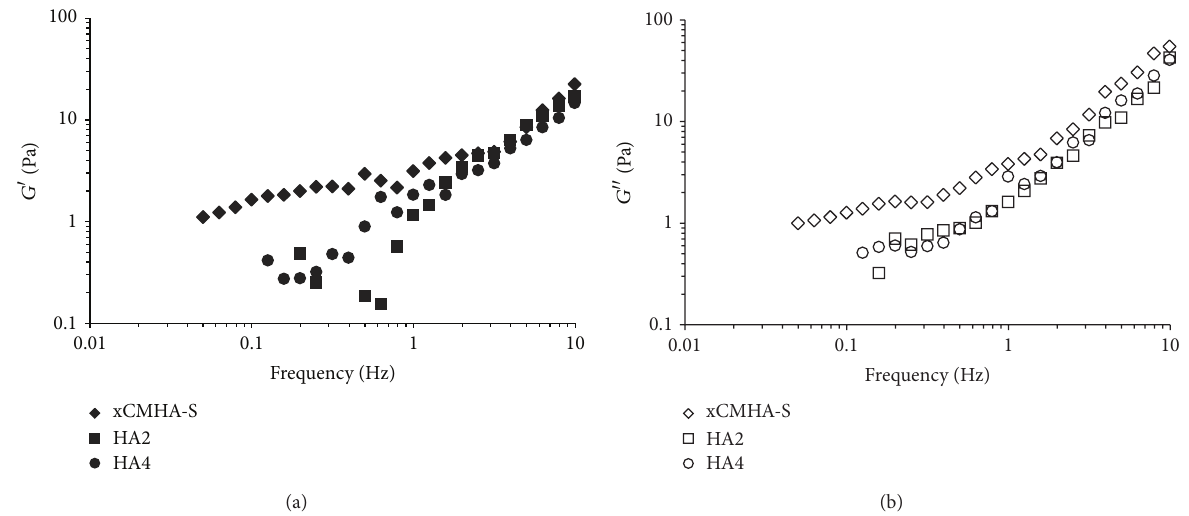
Figure2:(a)Elasticmodulus, 𝐺 󸀠 ,and(b)viscousmodulus, 𝐺 󸀠󸀠 ,ofthecrosslinkedCMHA-Sgel(xCMHA-S)andnoncrosslinkedHAsolutions (HA2 and HA4) as a function of